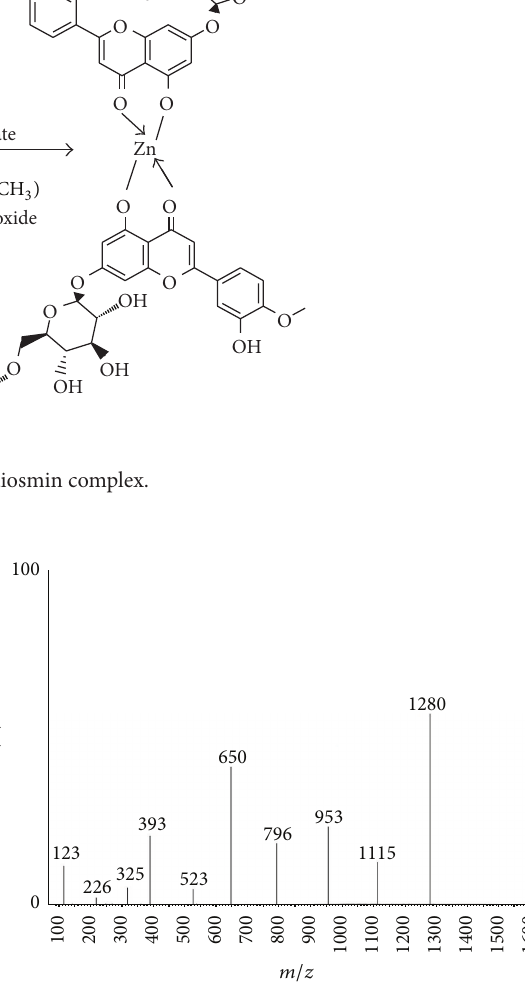
Figure 2: Mass spectrum of zinc-diosmin